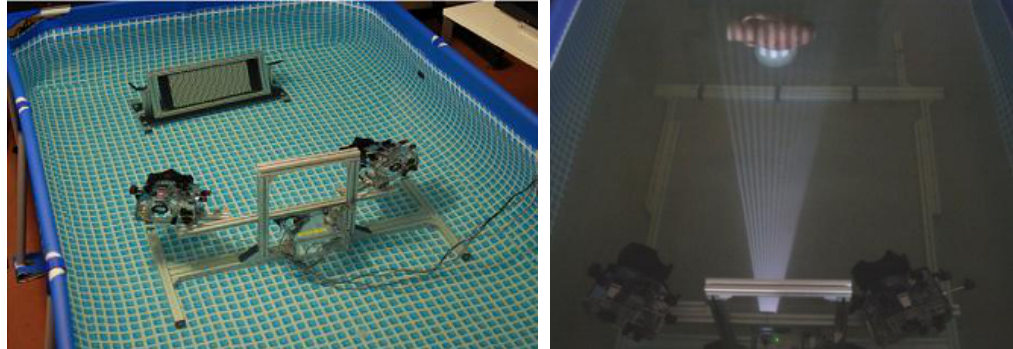
Figure 4. Optical setup of the underwater 3D acquisition system: underwater calibration ( Left ) and acquisition ( Right